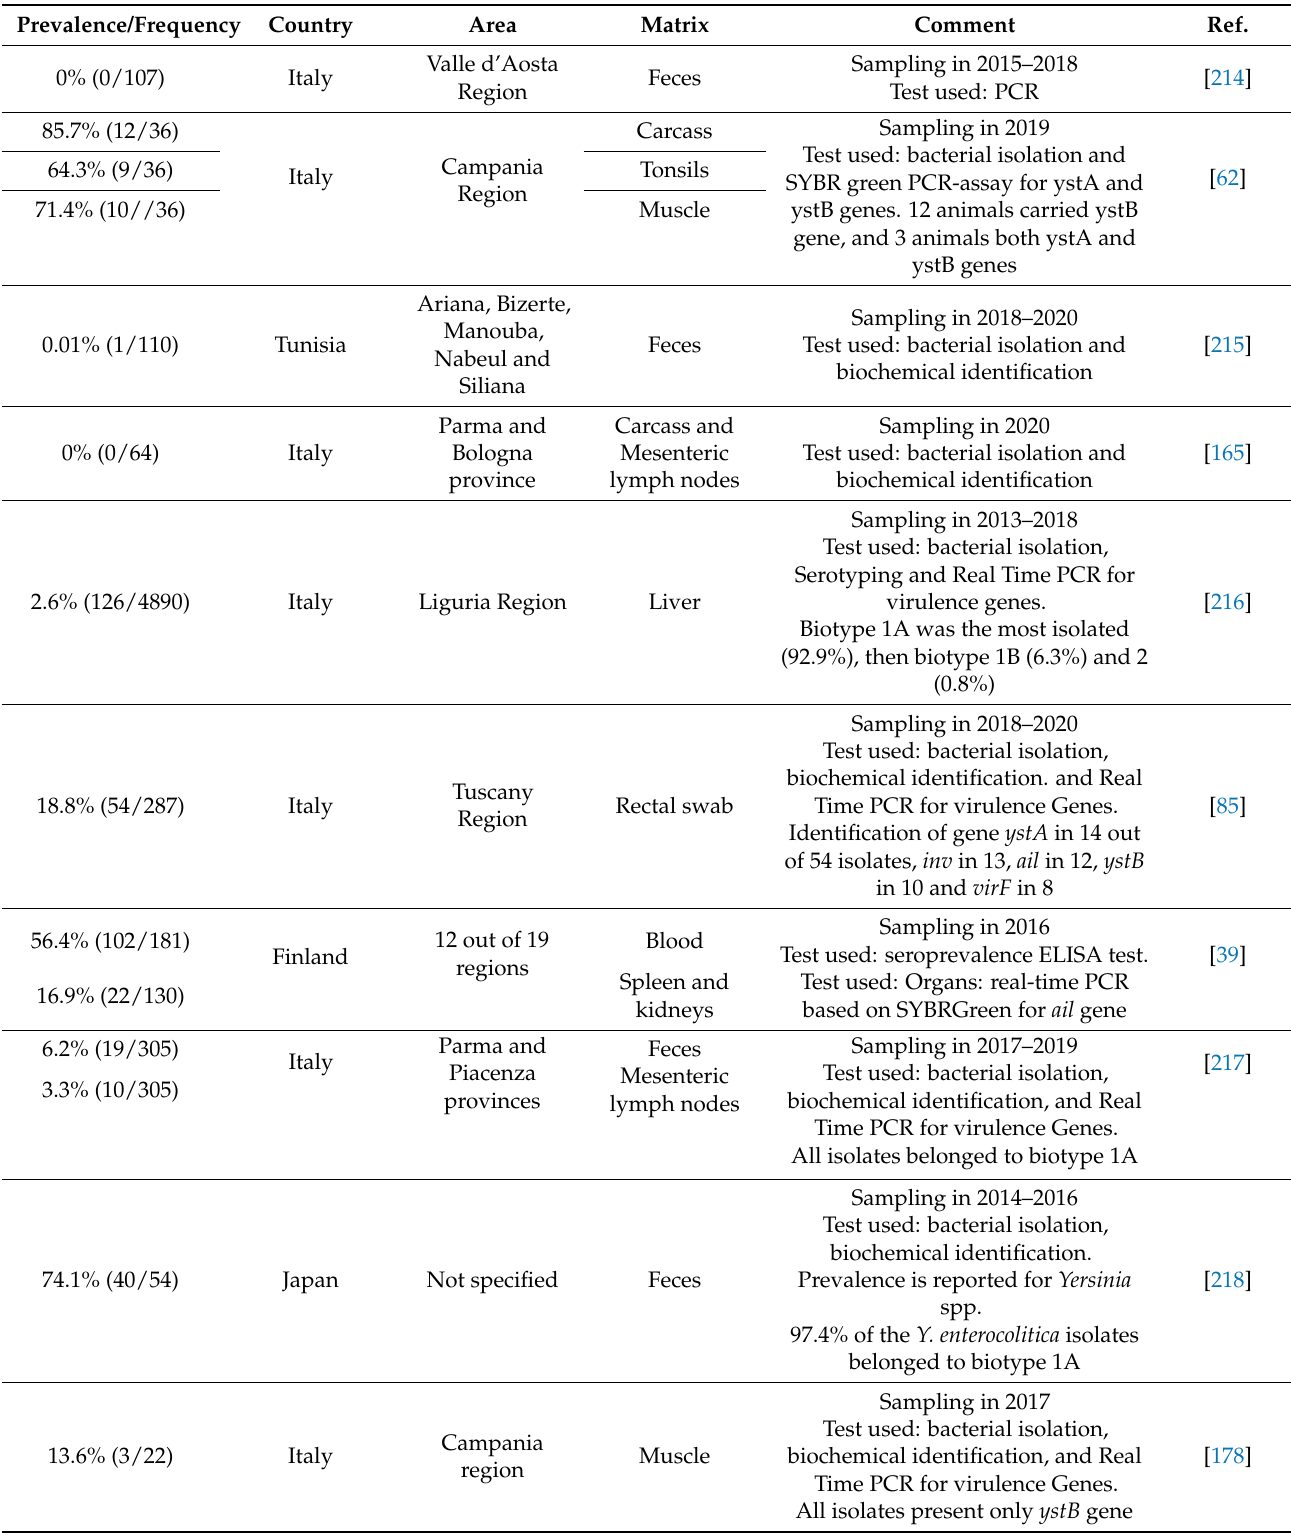
Table 14. Prevalence of Yersinia enterocolitica in wild boar, feral pigs and